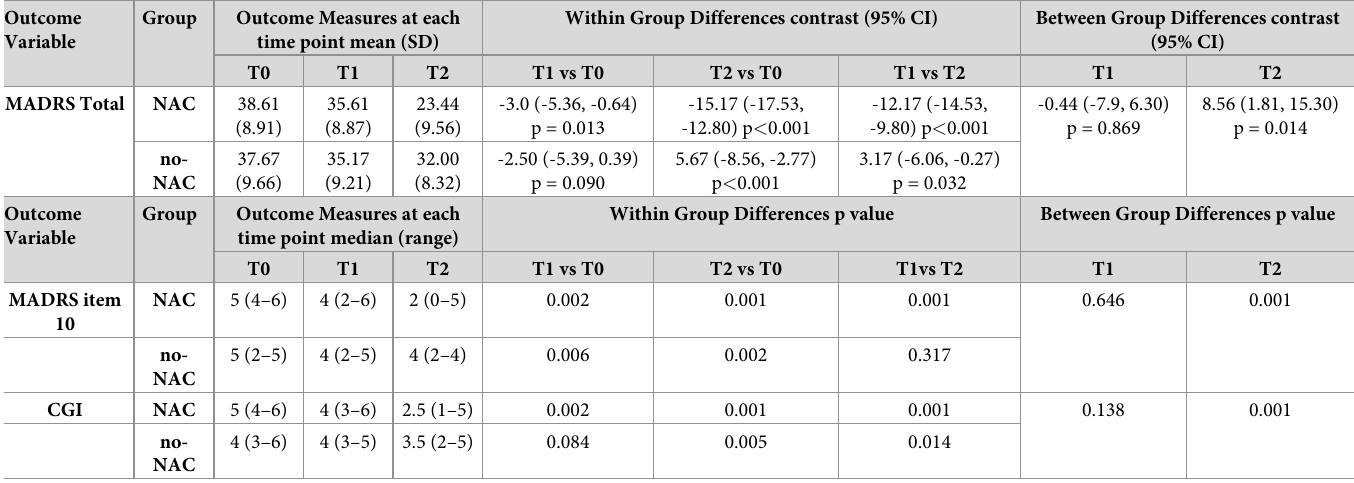
Table 3. Outcome measures at each time point for each group–within and between group differences. Outcome